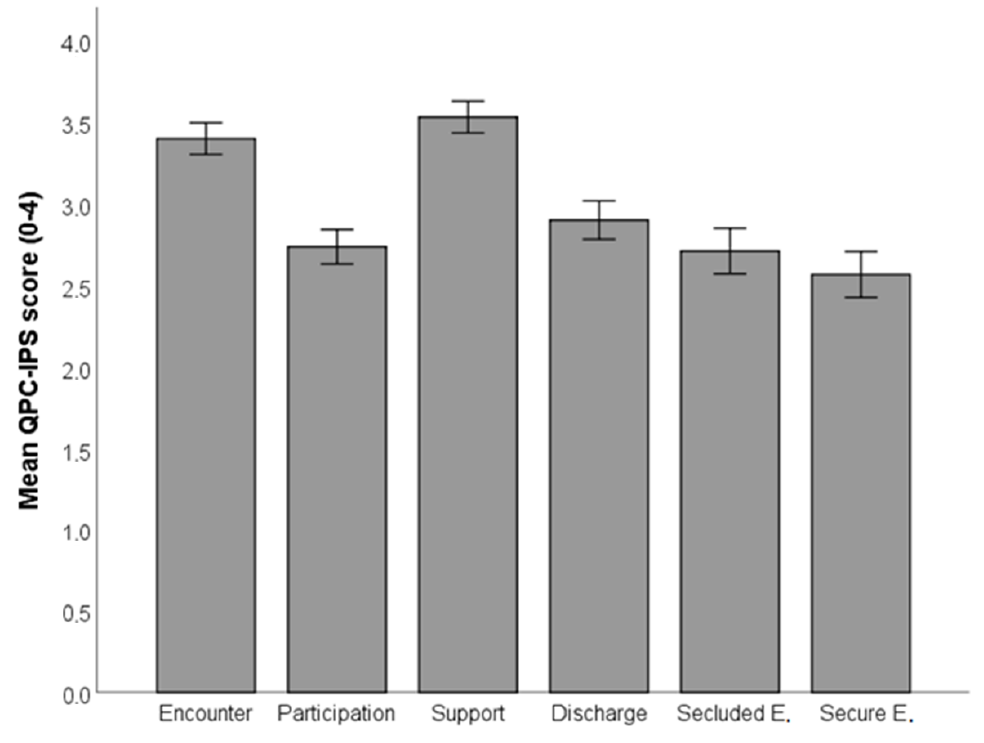
Figure 1. Mean QPC-IPS scores for each QPC-IPS dimension.